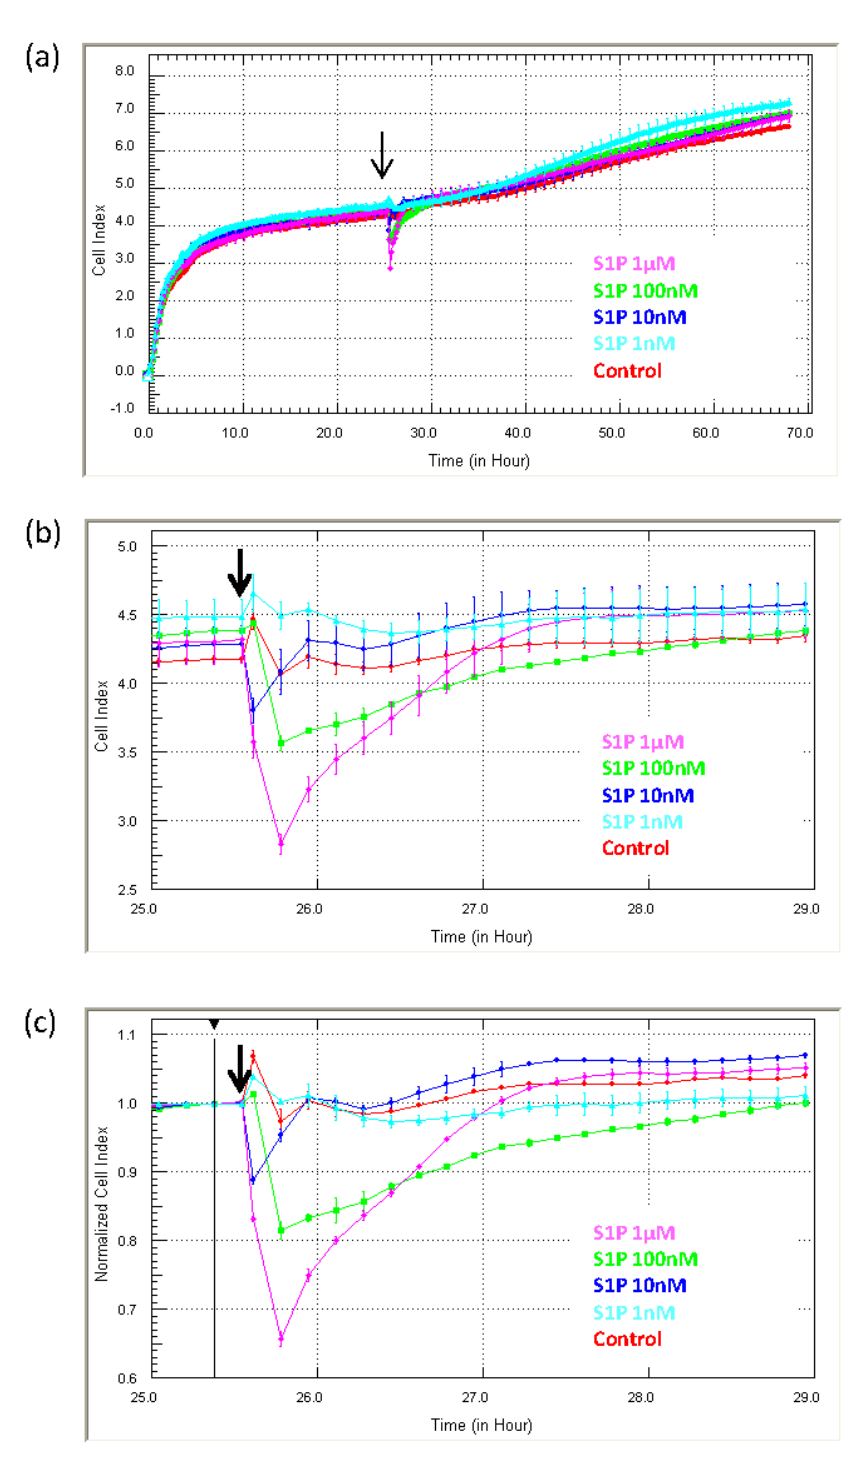
Figure 6. Measurement of rapid or transient cellular responses using xCELLigence. The usefulness of xCELLigence for monitoring acute transient responses is exemplified with the response of microvascular endothelial cells to sphingosine-1-phosphate (S1P). The response to S1P is immediate and transient, and xCELLigence reveals the precise timing and magnitude of the response. S1P was added at several concentrations (addition indicated by black arrow, 1 µM to 1 nM), which reveals a concentration-dependent response. The Normalised Cell Index plot is also used in conjunction with the Cell Index plots to determine the extent (%) of the response. Curves represent the Mean Cell Index value from >4 wells ±